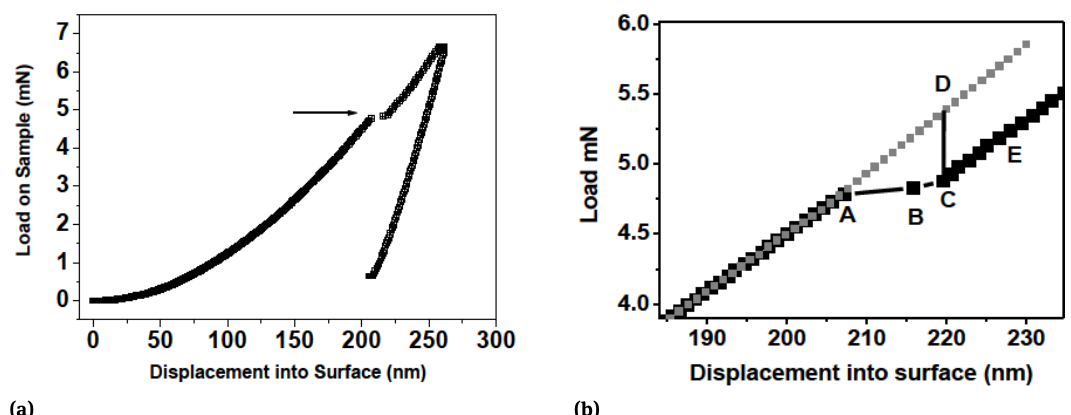
Figure 17: a) P–h plot with cube corner indenter for TiB 2 -Si. The fracture event is shown by the arrow b) Enlarged plot of the pop-in where the area ABCD gives the energy released due to the crack formation [264]